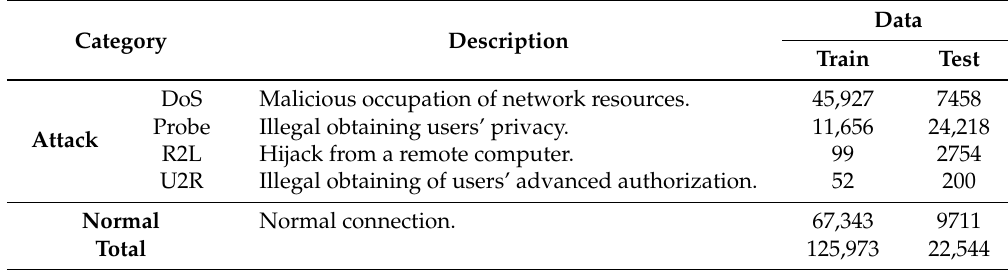
Table 2. Attack type distributions of NSL-KDD.